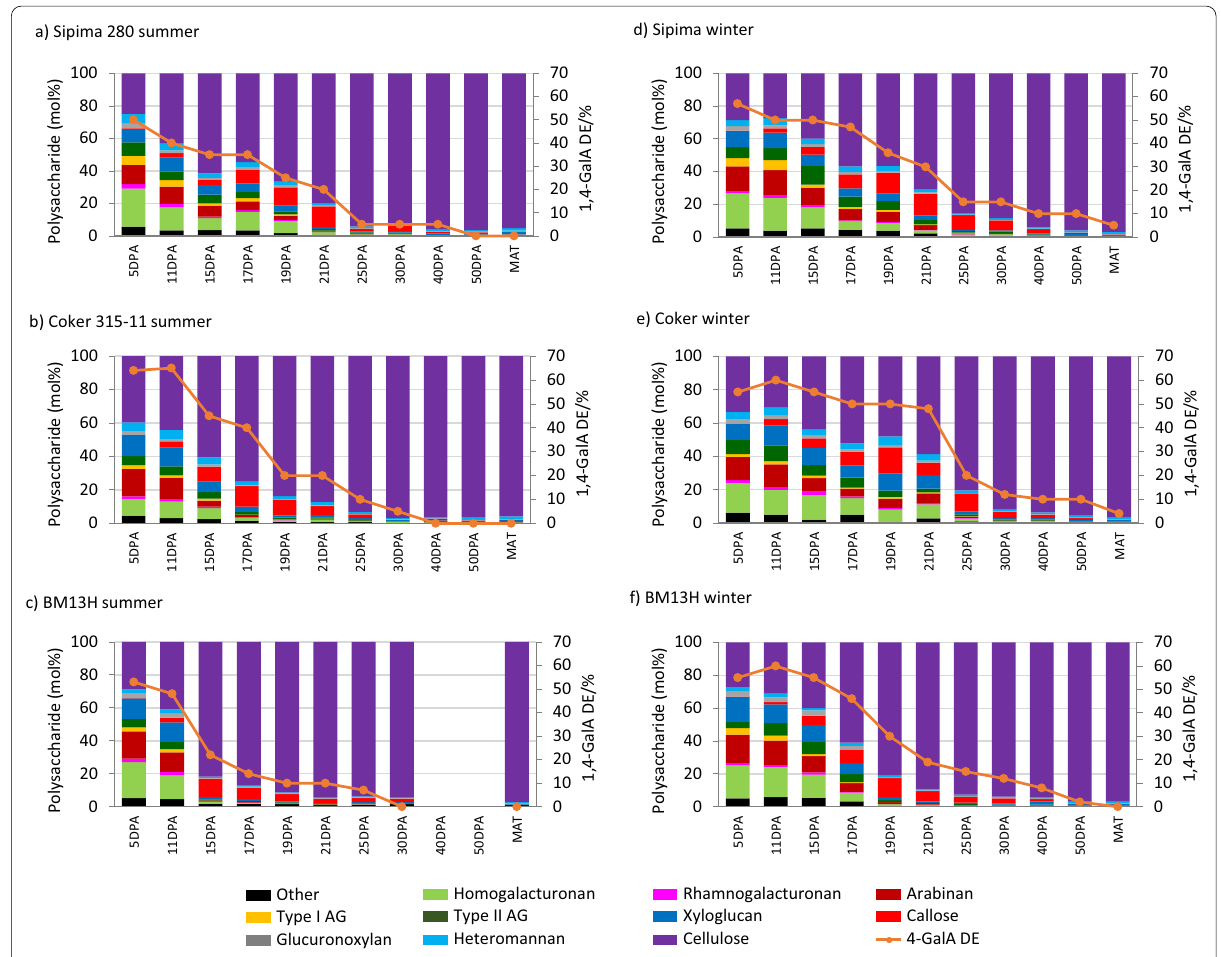
Fig. 1 Changes in polysaccharide composition (mol%) and pectin methylesterification (1,4-GalA DE) for a SiPima 280 ( G. barbadense ), b Coker 315-11 ( G. hirsutum ) and c BM13H ( G. arboreum ) cotton varieties through summer development and d SiPima 280 ( G. barbadense ), e Coker 315-11 ( G. hirsutum ) and f BM13H ( G. arboreum ) cotton varieties through winter development. Deduced from primary data in Additional file 1: Tables S1 and Additional file 2: Table